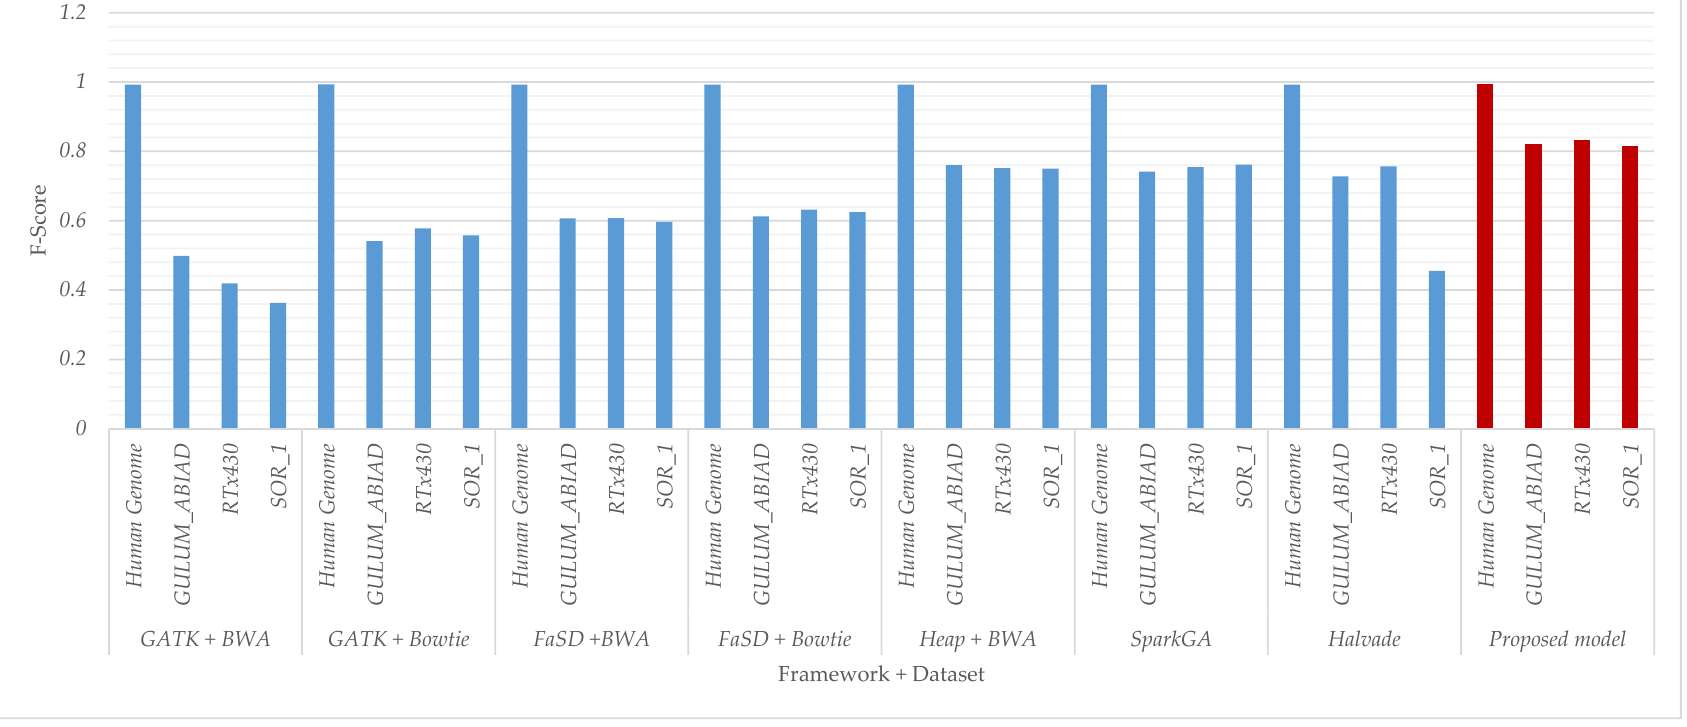
Figure 5. Comparative results analysis of proposed and existing workflows with respect to F-Score executed on the human genome and Sorghum datasets GULUM_ABIAD, RTx430, and SOR_1. The graph shows the F-score results for GATK + BWA, GATK + Bowtie, FaSD + BWA, FaSD + Bowtie, Heap + BWA, SparkGA, Halvade and proposed workflows respectively. The solid blue bars show the F-score for existing workflows while the solid filled dark-red vertical bars show the F-score result for the proposed workflow. From graphs, it is clear that the proposed workflow has achieved better results as compared to others.